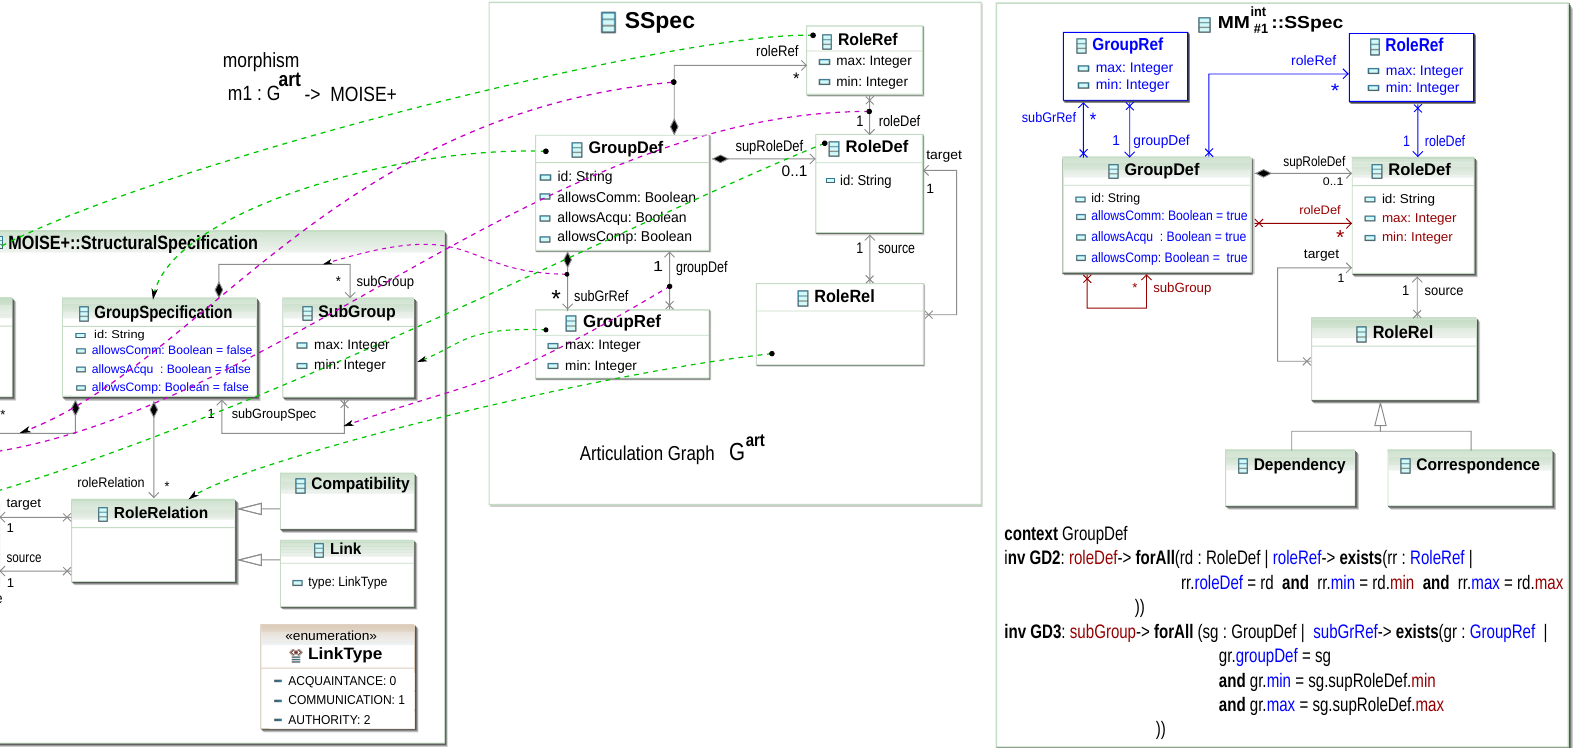
Figure 8. Alignment between MOISE+ and MM int